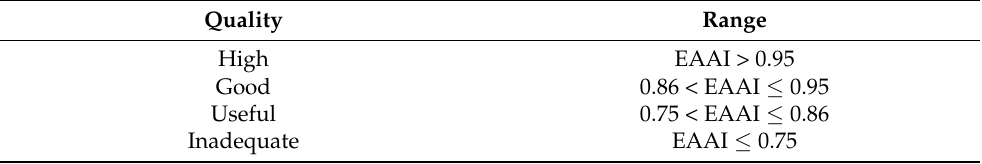
Table 1. Protein quality classification based on the essential amino acid index (EAAI) [52].